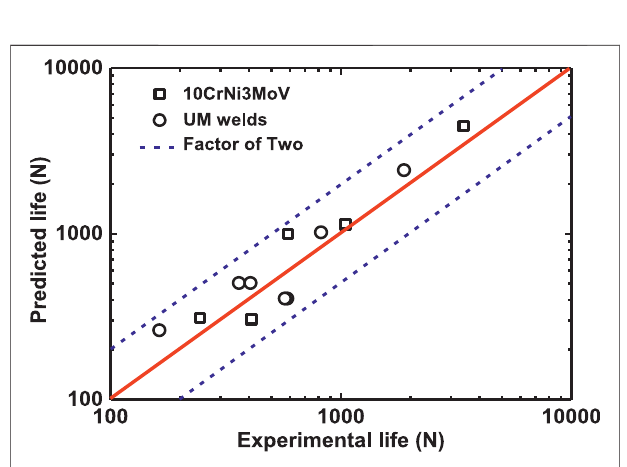
FIGURE 16 | Fatigue life prediction of different